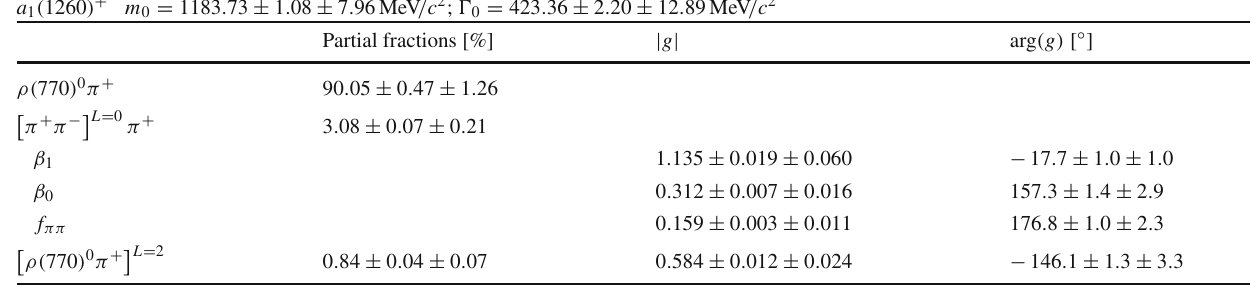
Table 20 Table of fit fractions and coupling parameters for the compo- nent involving the a 1 ( 1260 ) + meson, from the fit performed on the RS decay D 0 → K − π + π + π − . The coupling parameters are defined with